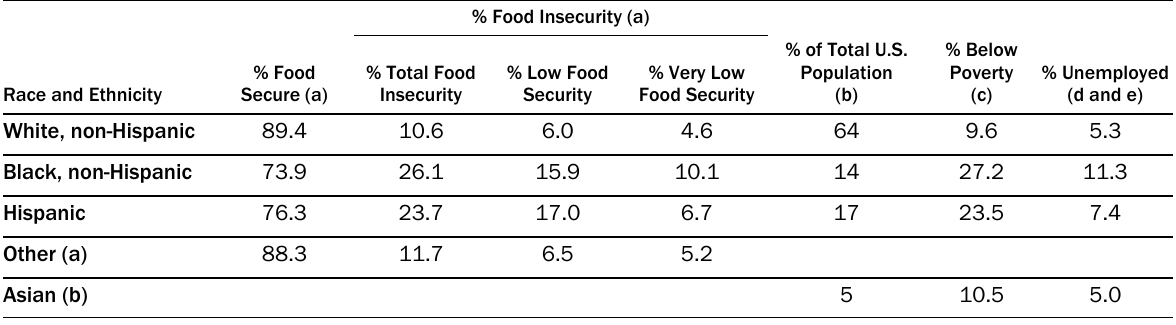
% Food Insecurity (a)